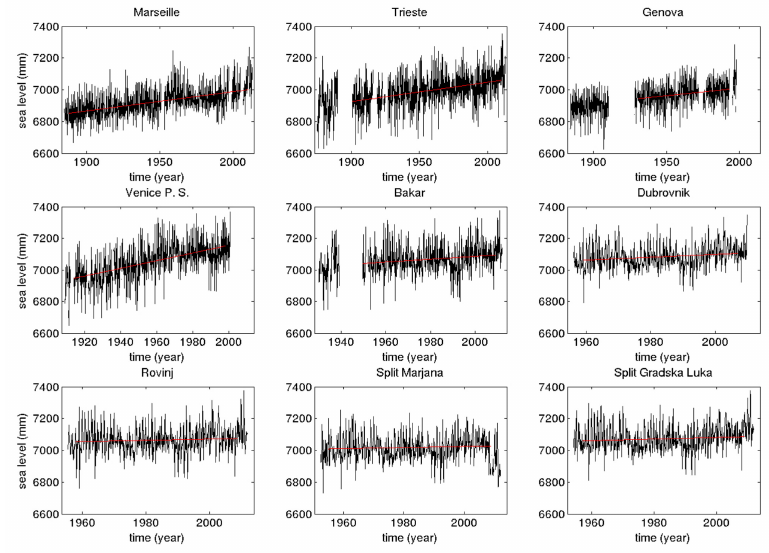
Figure 2. Time series of the monthly mean tidal records from stations in Figure 1 (data from www.psmsl.org). Red lines show linear regressions on the data (see the text for